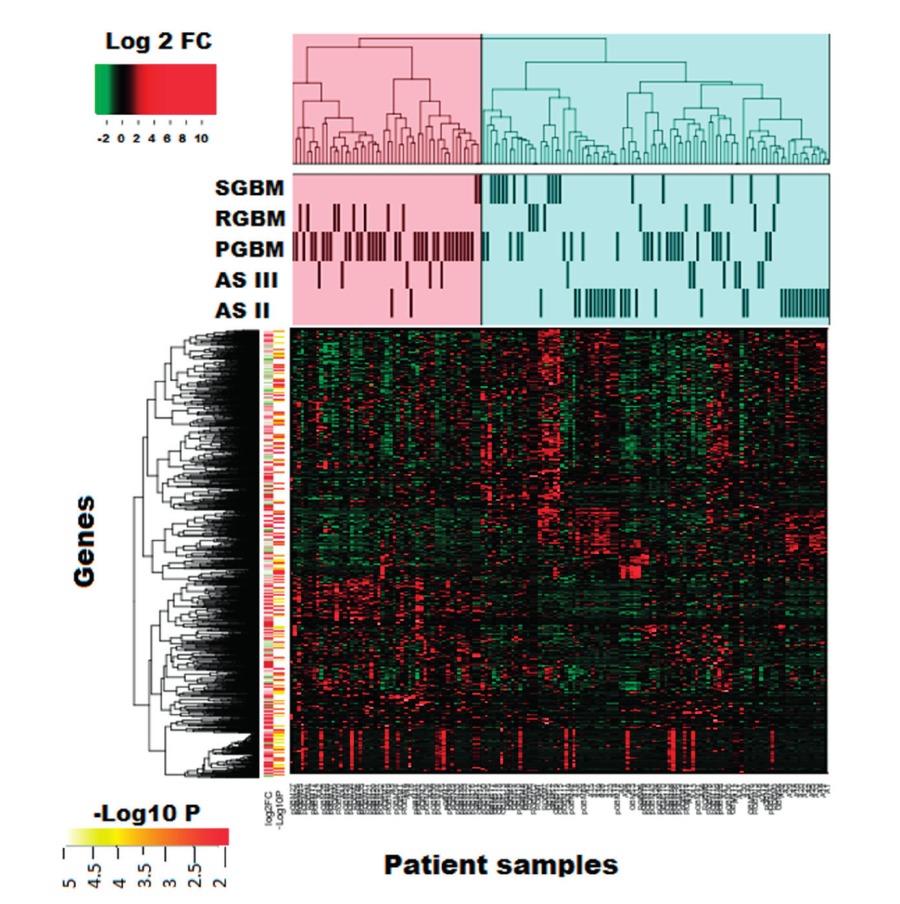
Fig. 3. Expression of transcription factors in AS II - IV. Heat map of transcription factors in different grades of astrocytoma. Heat map was generated from a list of 1446 transcription factor genes in different astrocytoma grades. A clear difference between grade II and grade IV was observed. Primary GBM samples showed a different expression pattern when compared to grade II astrocy- toma. A cluster of transcription factor genes were shared among grade IV